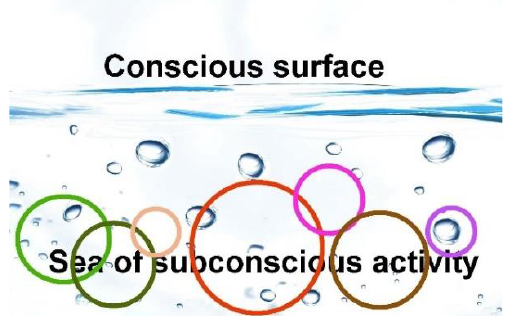
Figure 2. A model of consciousness. The brain can be portrayed as a sea of activity, where the surface represents the conscious. The functions, or apps (depicted as circles), are embedded in the subconscious (or nonconscious) sea. Some are more important as to conscious content (larger circles) than others. From there, they send bubbles toward the surface. The bubbles that reach their destination fuse to form a moment of conscious experience.